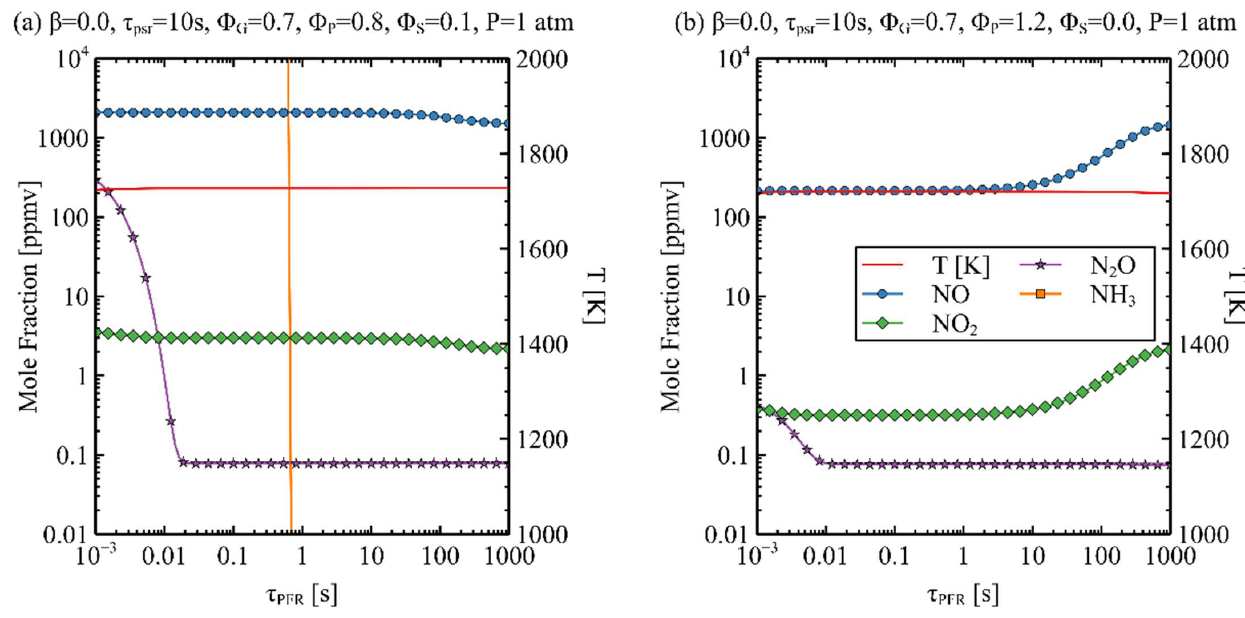
Figure 7. NOx and temperature versus 𝜏 (cid:3017)(cid:3007)(cid:3019) for 𝜙 (cid:3008) = 0.7. ( a ) FS, ( b ) AS.